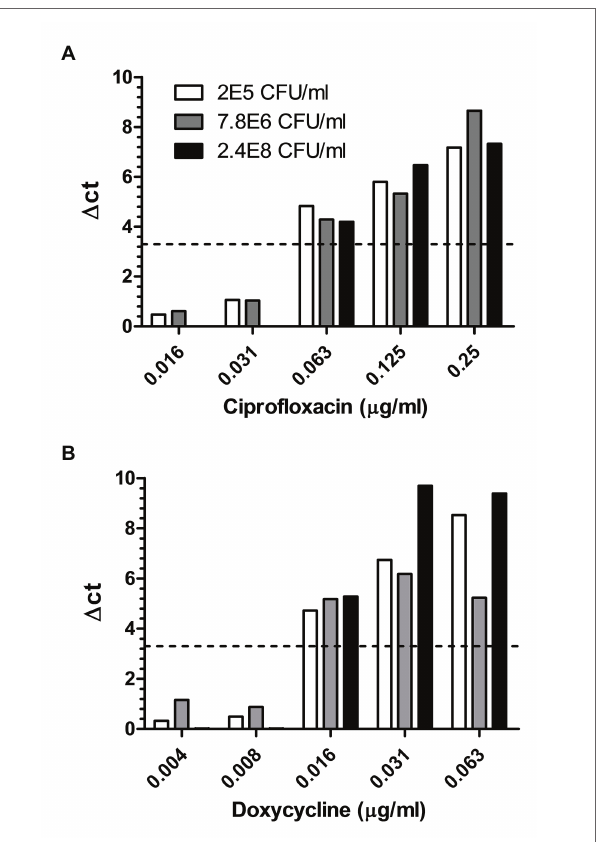
FIGURE 2 | Soiled samples spiked with different concentrations of B. anthracis spores. Different soiled samples spiked with 2.4E8, 7.8E6, and 2E5 cfu/ml of B. anthracis were subjected to MAPt. MIC was determined, as described in materials and methods, by the thresholds of ∆ CT = 3.3. (A) Ciprofloxacin and (B)